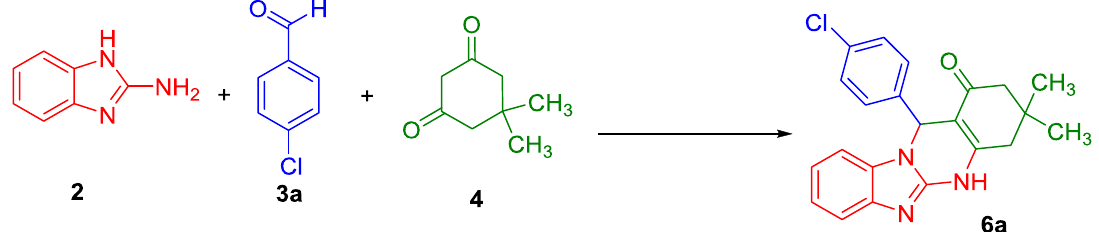
Reaction conditions: 2-aminobenzoimidazole ( 2 , 1 mmol) and 4-chlorobenzaldehyde ( 3a, 1 mmol) and dimedone ( 4 , 1 mmol) under solvent-free conditions (unless solvent indicated, 2 mL). a Isolated